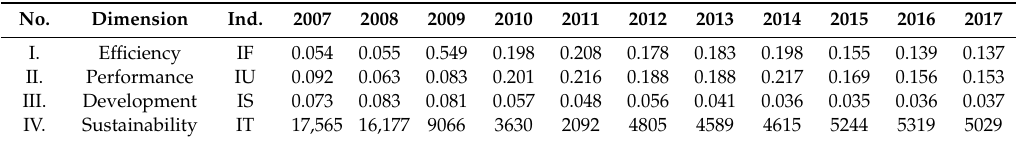
Table 8. Values of nonbank financial institutions’ indicators for the period